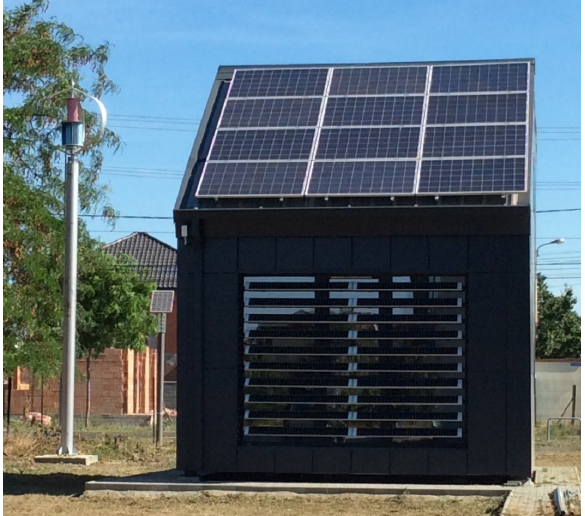
Figure 5. South view of the built LSF experimental module.